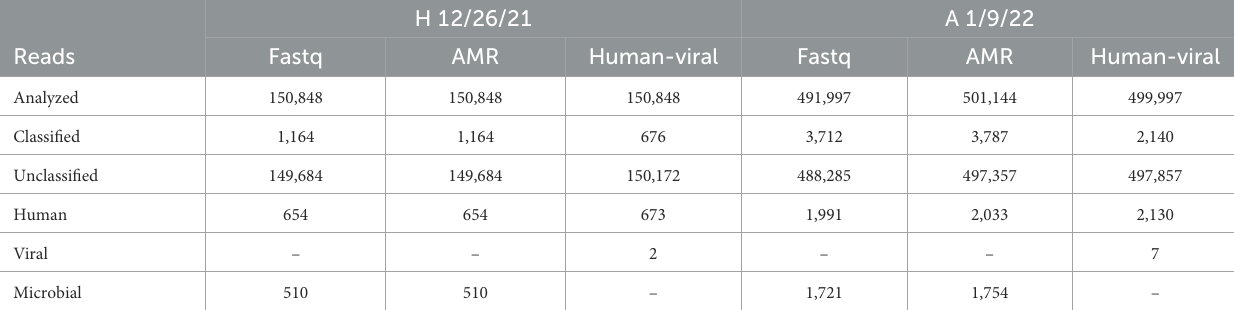
TABLE 5 Distribution of read classification by WIMP option (Fastq, Antimicrobial Resistance (AMR), or human-viral) for H 12/26/21 and A 1/9/22 samples demonstrated that the direct RNA MinION sequencing method did not provide useful information on pathogens prevalence. H